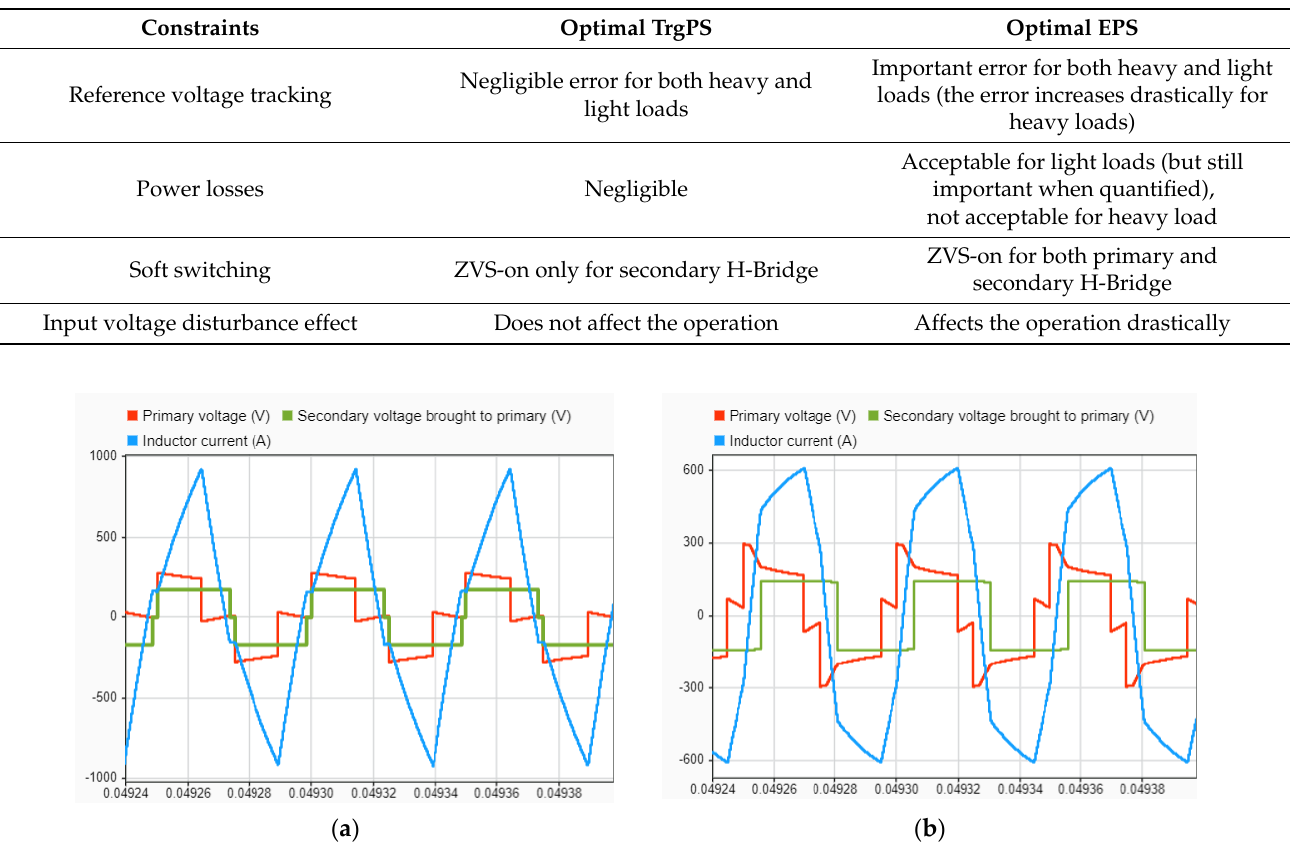
Table 3. Circuit parameters’ variation with respect to EPS operating mode.